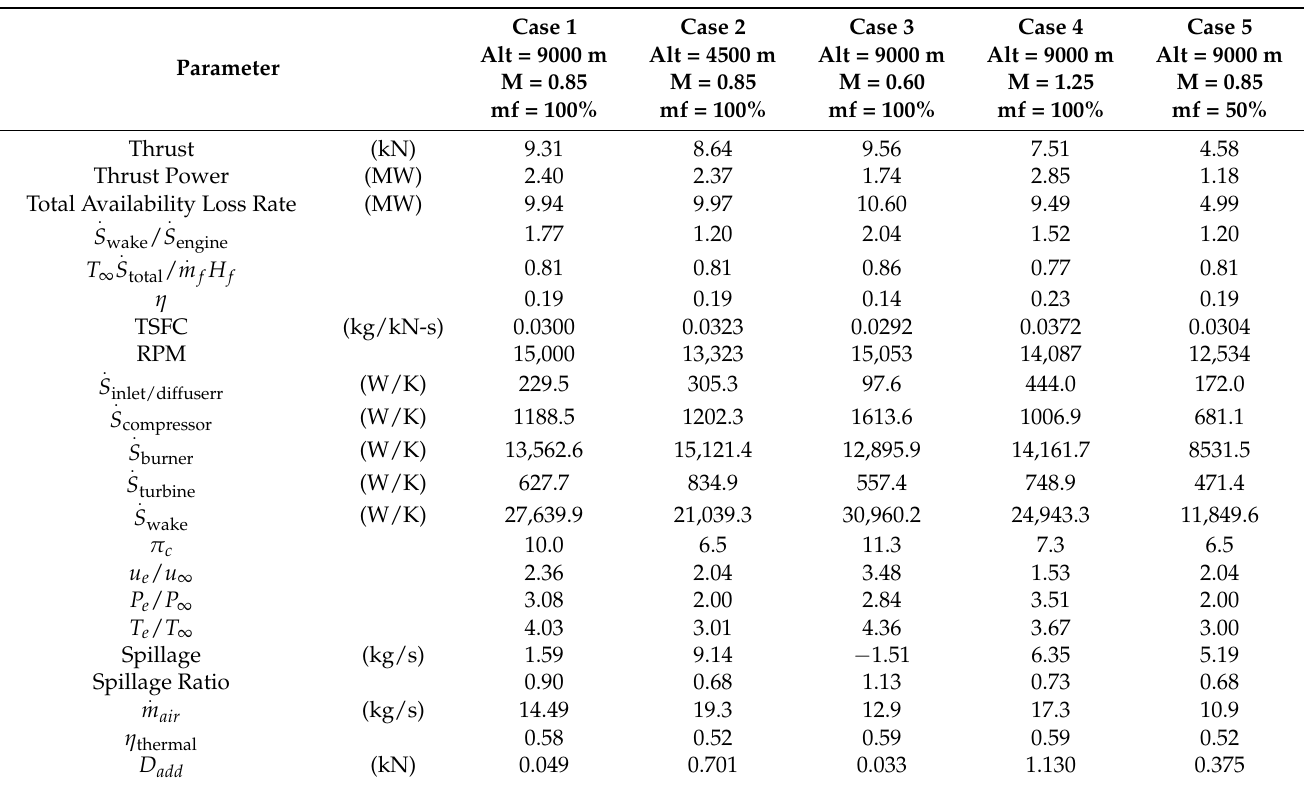
Table 3. Comparative parameter values for engine on- and off-design